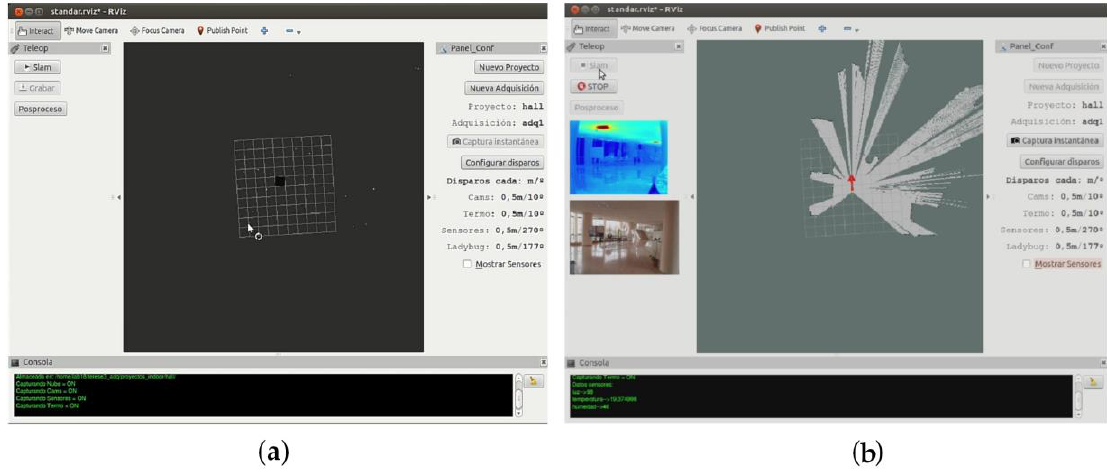
Figure 4. Screen captures of the software developed for controlling data acquisition at: ( a ) standby mode; and ( b ) working mode.